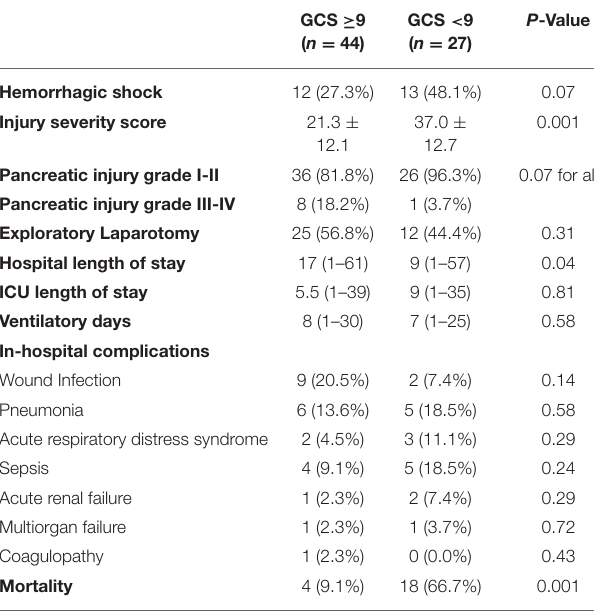
TABLE 3 | Pancreatic injury by Glasgow coma scale.